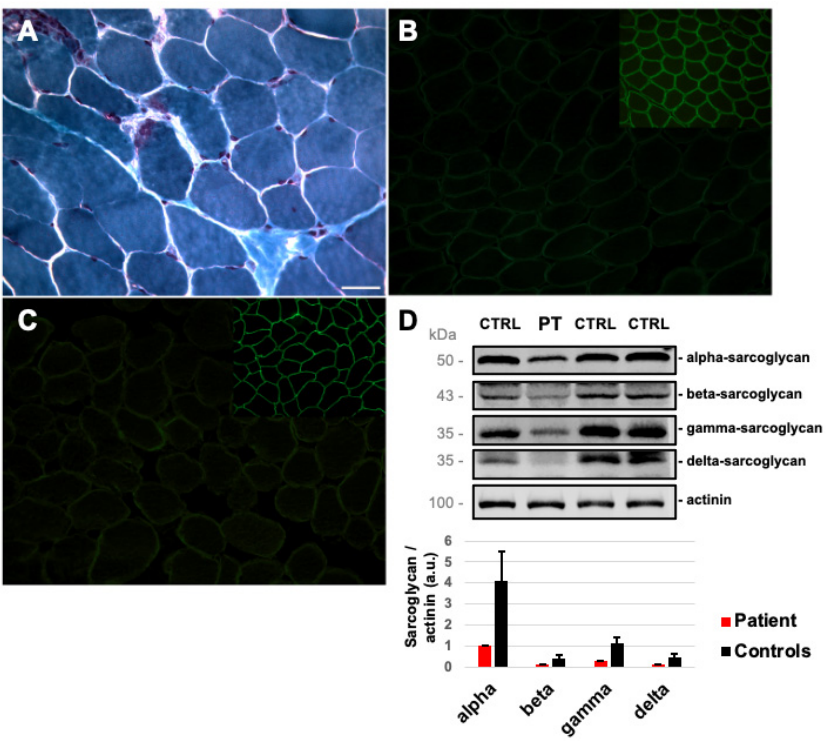
Figure 1. Skeletal muscle involvement in our Patient: ( A ) Modified Gomori Trichrome on patient’s muscle section showing the presence of necrotic fibers. Immunofluorescent staining for alpha- sarcoglycan ( B ) and gamma-sarcoglycan ( C ) (insert: alpha- and gamma-sarcoglycan in control muscle sections). Magnification 20×. Scale bar 50 μ m. ( D ) Western blot analysis of sarcoglycans proteins and muscle actinin used as a reference in patient’s (PT) and control (CTRL) muscle biopsies. Protein levels of sarcoglycans normalized to actinin are reported in the bar chart (error bars mean standard deviations among controls, n = 3).